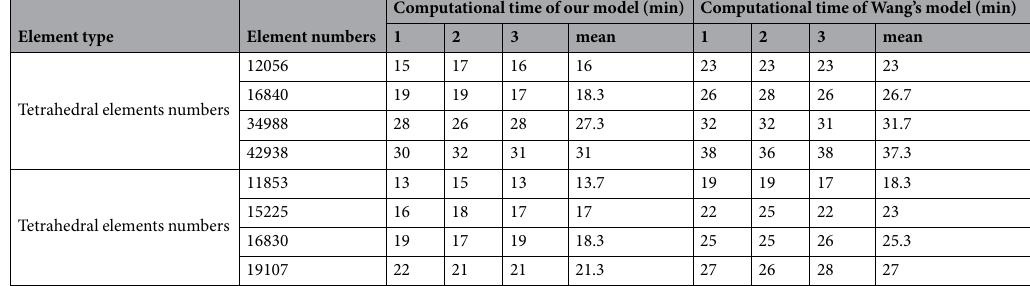
Table 2. Comparison of computational time between our model and Wang’s 9 model under Case